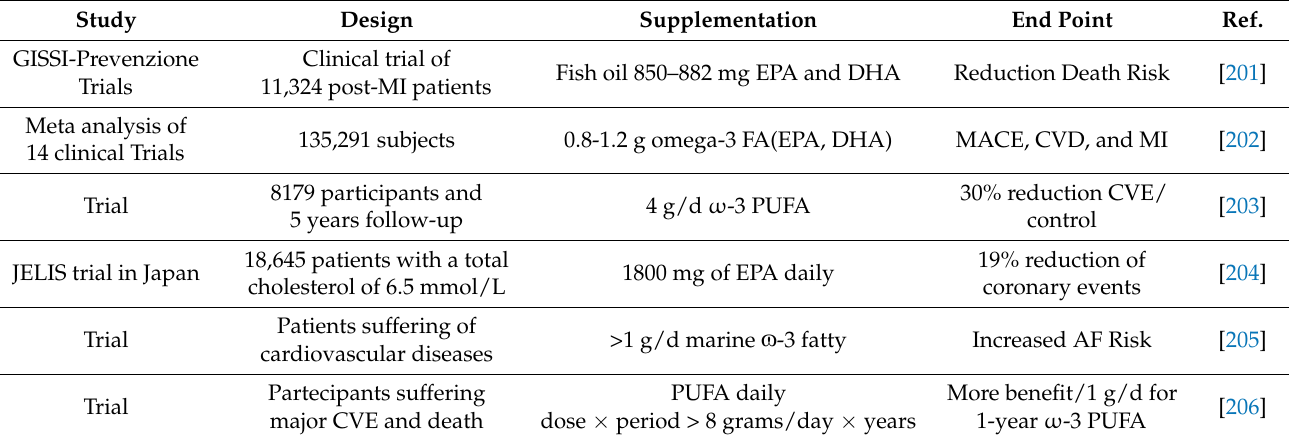
Table 3 . Trials on ω -3 fatty acid diet in Table 3. Trials on ω -3 fatty acid diet in humans.